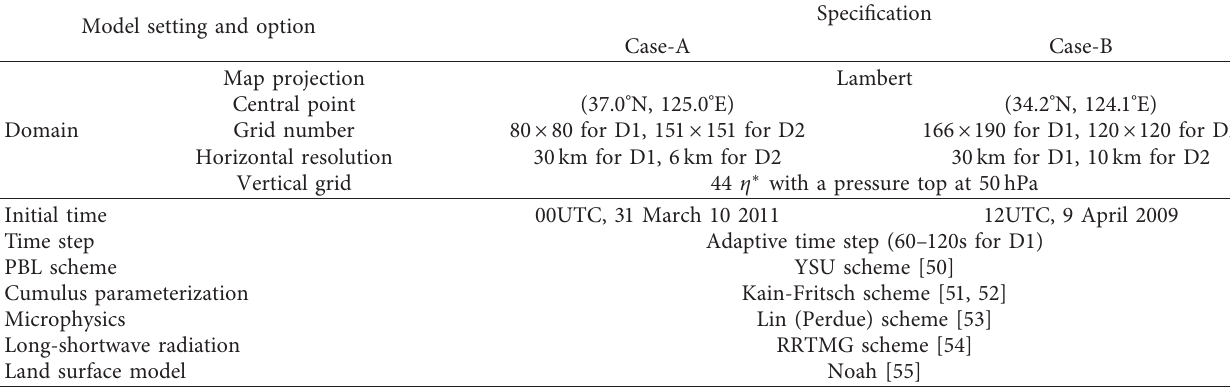
Table 1: Configurations of the weather research and forecasting (WRF).